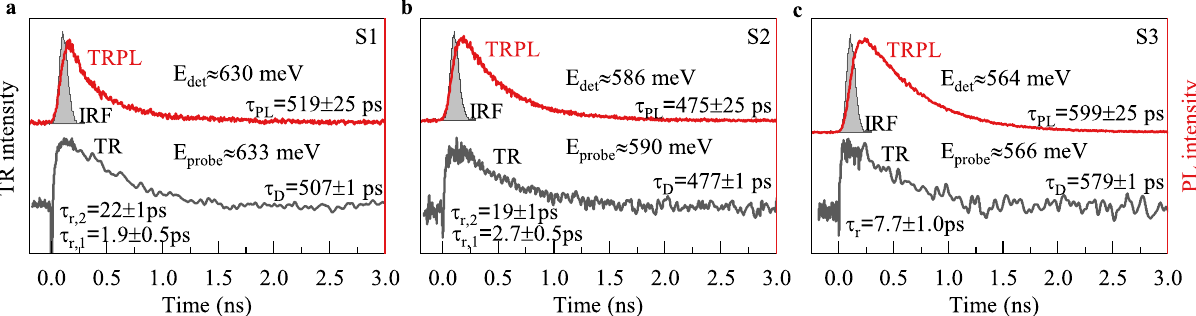
Figure 4. Examples of recorded low-temperature ( T = 4.2K ) time-resolved photoluminescence (TRPL) (solid red lines) and transient reflectivity (TR) traces (solid black lines) for (Ga,In)(Sb,Bi)/GaSb QWs with the nominal Bi content of ( a ) 6%, ( b ) 7%, and ( c ) 8%. The IRF (grey shaded area) represents the instrumental response function for the TRPL setup. E det and E probe are detection energy in the TRPL experiment, and the probe pulse photon energy in the TR experiment, respectively. The excitation power density in both experiments is the same, P ≈ 40Wcm − 2 pump